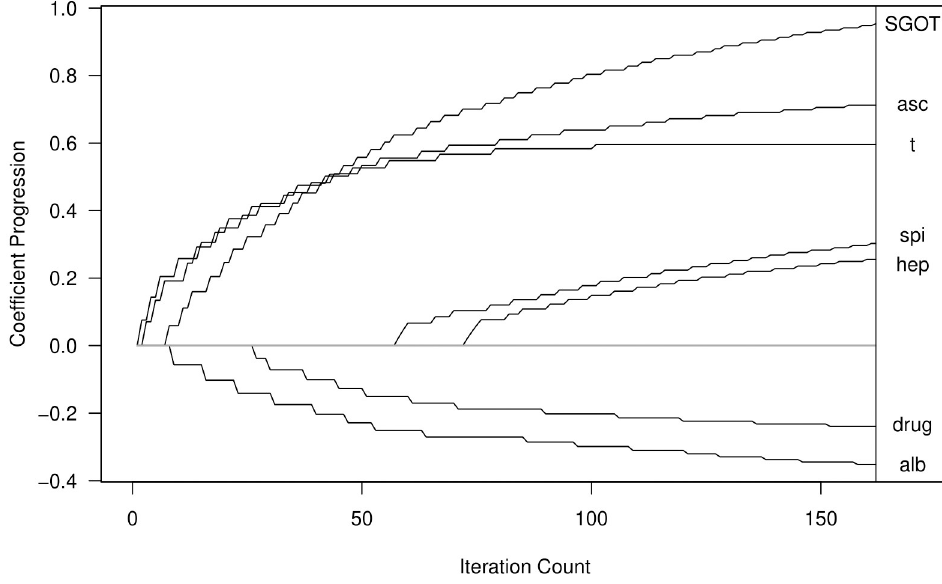
Fig 3. Coefficient progression for the PBC data obtained by lbbLMM with m � =